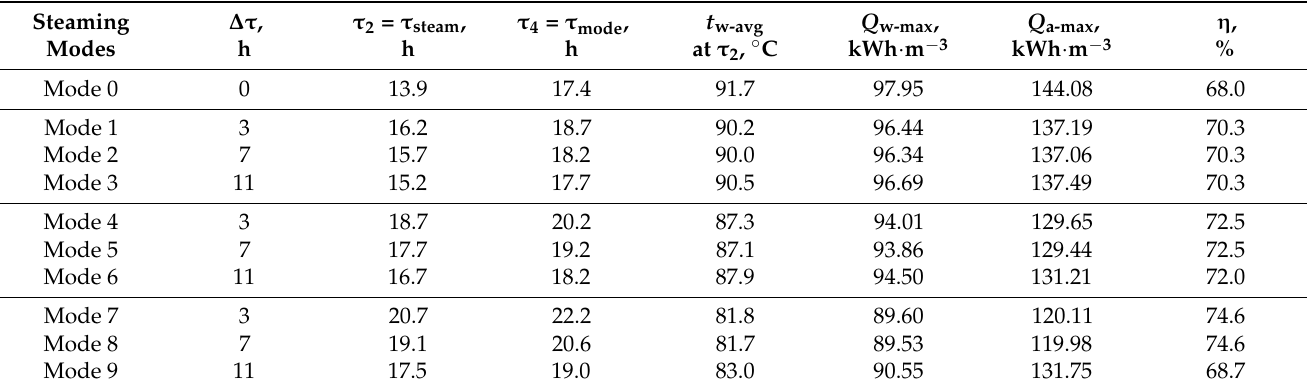
Table 2. Change in τ steam , τ mode , t w-avg at τ 2 , Q w-max , Q a-max , and η of the studied steaming modes, depending on ∆ τ